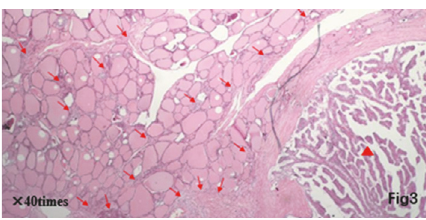
Figure 3: Red triangle for large carcinoma lesions at the lower right corner;redarrowforsmalllesionscomposedofdozensofheterocyst reunion on the left side.